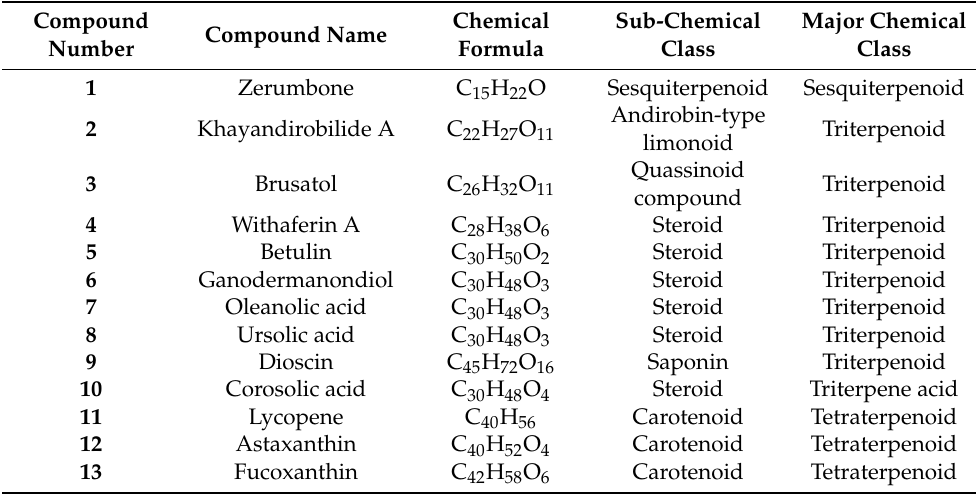
Figure 1. Nutraceuticals can alter and inhibit the specific cellular and metabolic pathways associated with breast cancer development [36–38]. Table 1. Dietary terpenoid phytochemicals which can modulate the Keap1-Nrf2-ARE signaling system and their chemical classes.